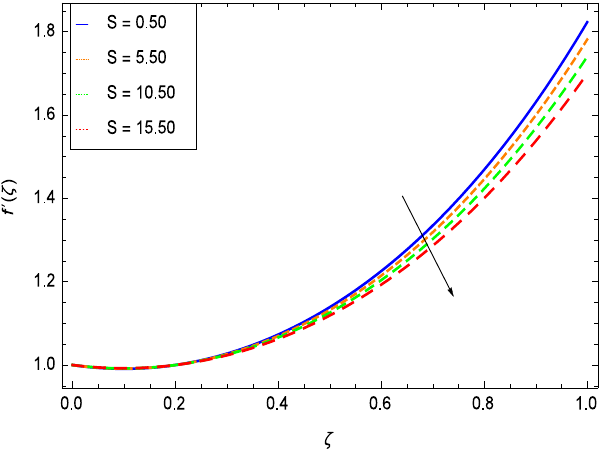
Figure 6. Flow layer at h = − 3.00, β = 0.10, φ = 0.40, n = 1.50, We = 0.50, M = 2.00, A = π enhancement in S